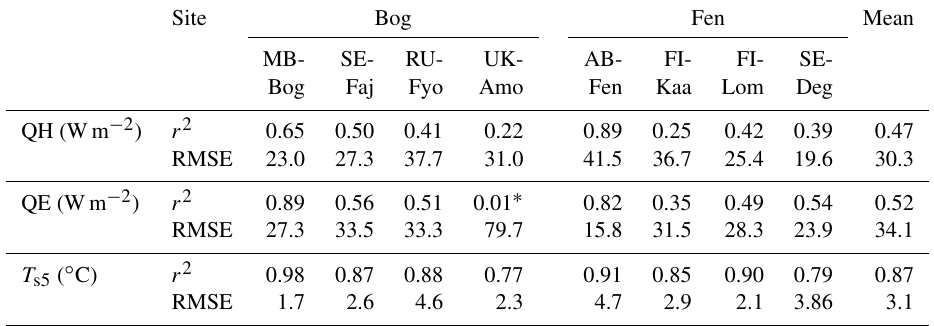
Table 5. Summary of statistics of model performance with respect to daily average latent heat flux (QH), sensible heat flux (QE), and soil T at 5cm ( T s5 ). ∗ Indicates unrealistic values observed for the site.